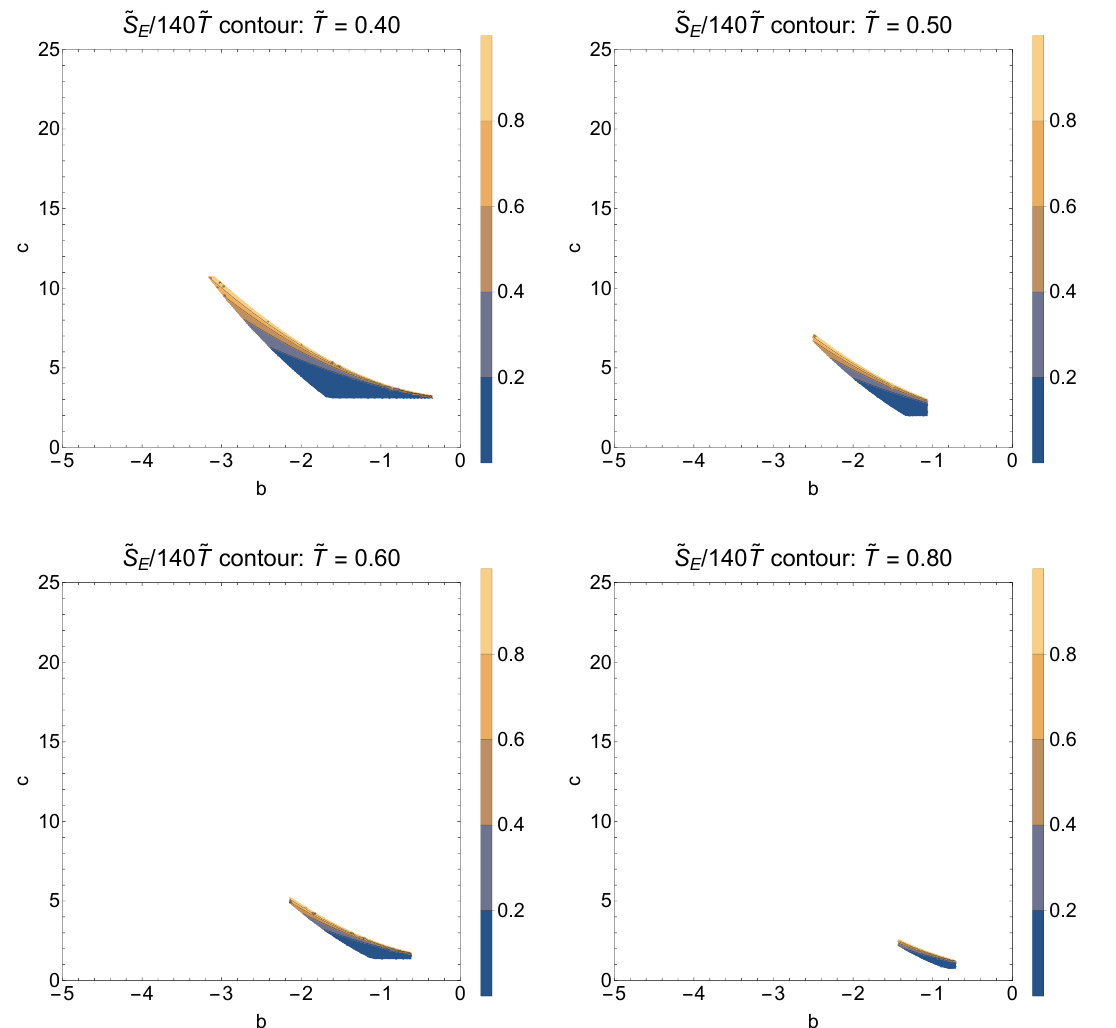
˜ ˜ S E / 140 T are shown in the ( b, c ) plane for larger values of 140 ˜ T ≤ 1 , ˜ β/H ≥ ˜ S E /